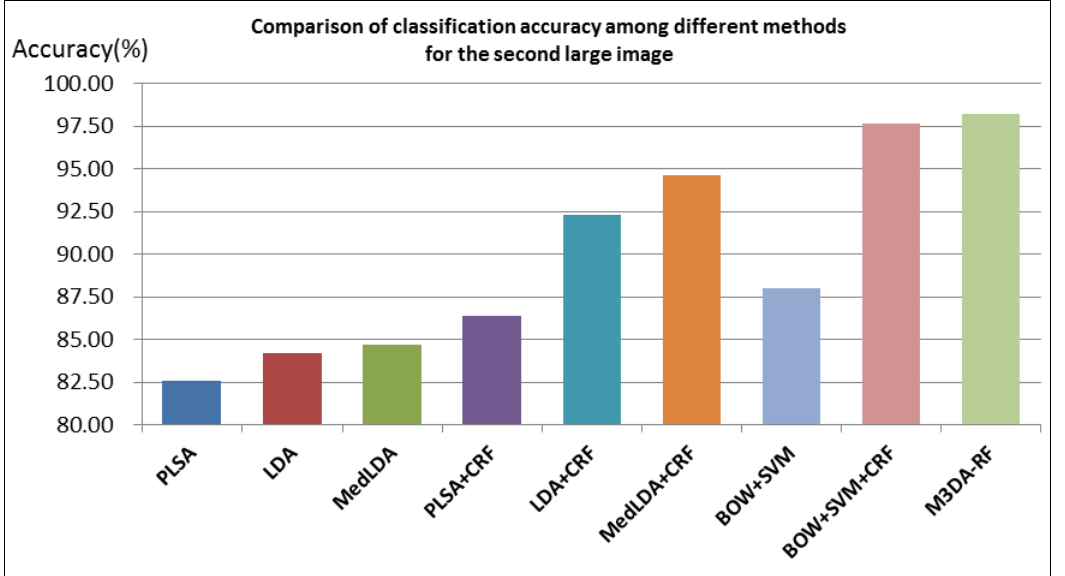
Figure 8. Comparison of annotation accuracy among different methods for image I.